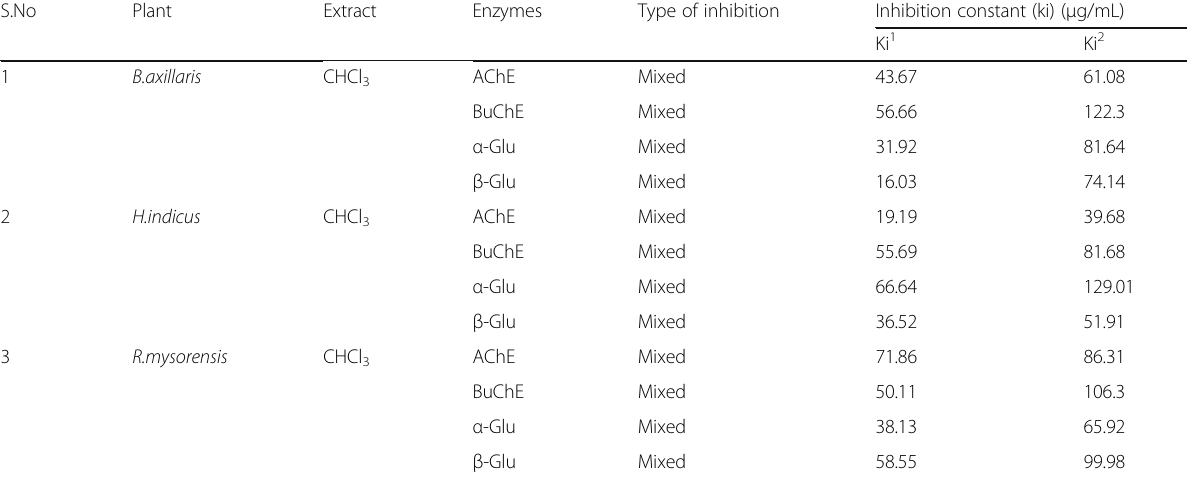
Table 3 Kinetic study of most active fractions BAC, HIC and RMC on AChE, BuChE and α - and β -glucosidase enzyme inhibition S.No